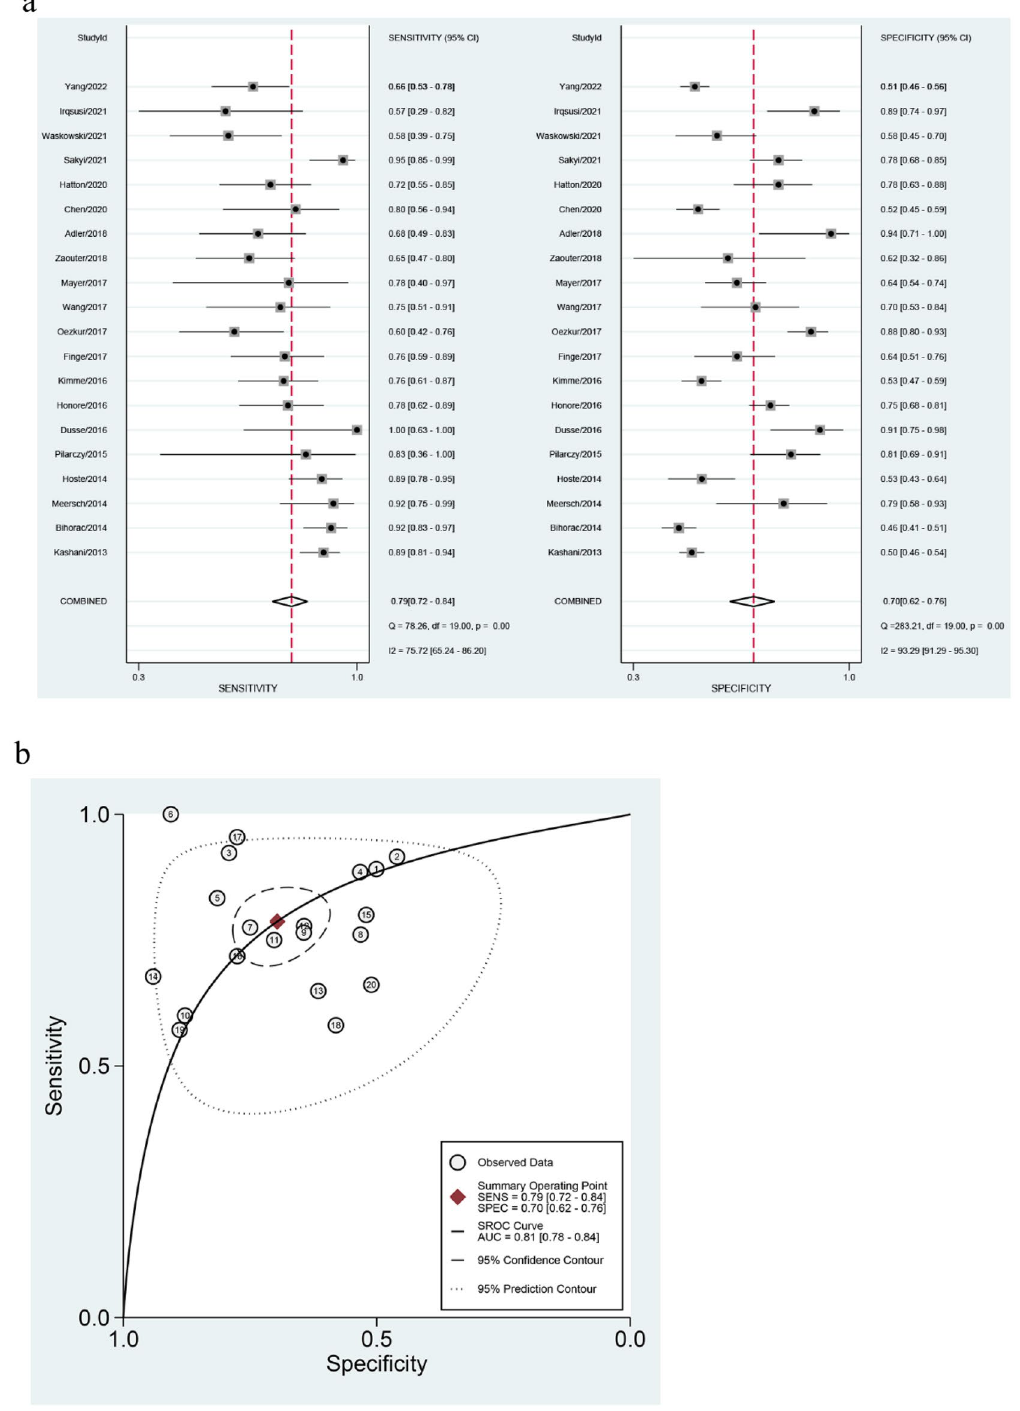
Figure 3. ( a ) Forest plot of the pooled sensitivity and specificity of urine [TIMP-2] × [IGFBP7] in predicting acute kidney injury. ( b ) Summary receiver operating characteristic graph for the included studies. The curve is represented by the straight line; each of the analyzed studies is represented by a circle; the point estimate to which summary sensitivity (SENS) and specificity (SPEC) correspond is represented by the diamond shape, and the respective 95% confidence intervals, by the dashed line, whereas the 95% confidence area in which a new study will be located is represented by the dotted